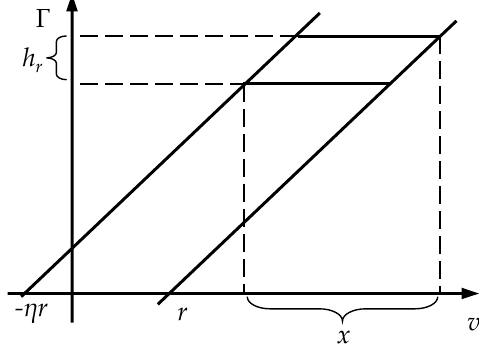
Figure 7. Geometric relations of the minor loop of M-Play operators.